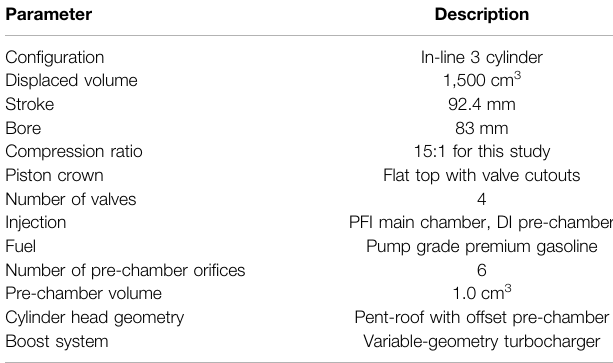
TABLE 1 | Engine speci fi